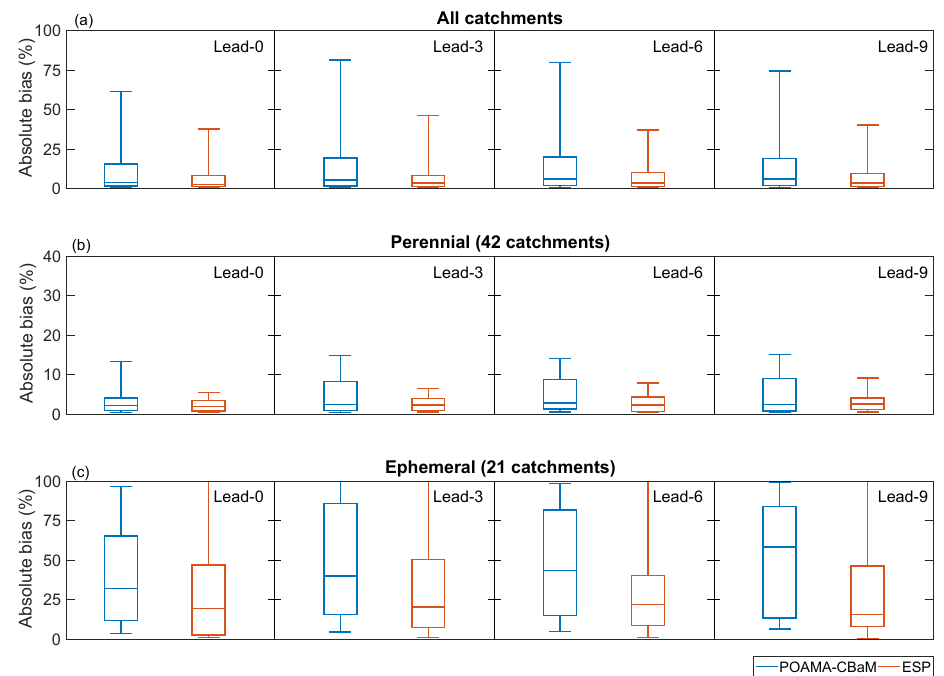
Figure 8. Absolute bias in 63 catchments by lead time for FoGSS forecasts forced by forecast (POAMA-CBaM) and historical (ESP) rainfall. For each lead time, absolute bias is calculated for all months, and then summarized for all catchments with box and whisker plots. Boxes show the interquartile range with the median; whiskers give the 10th and 90th percentiles. (a) shows all catchments, (b) shows perennial catchments, and (c) shows ephemeral catchments. Note the differently scaled vertical axis of (b)